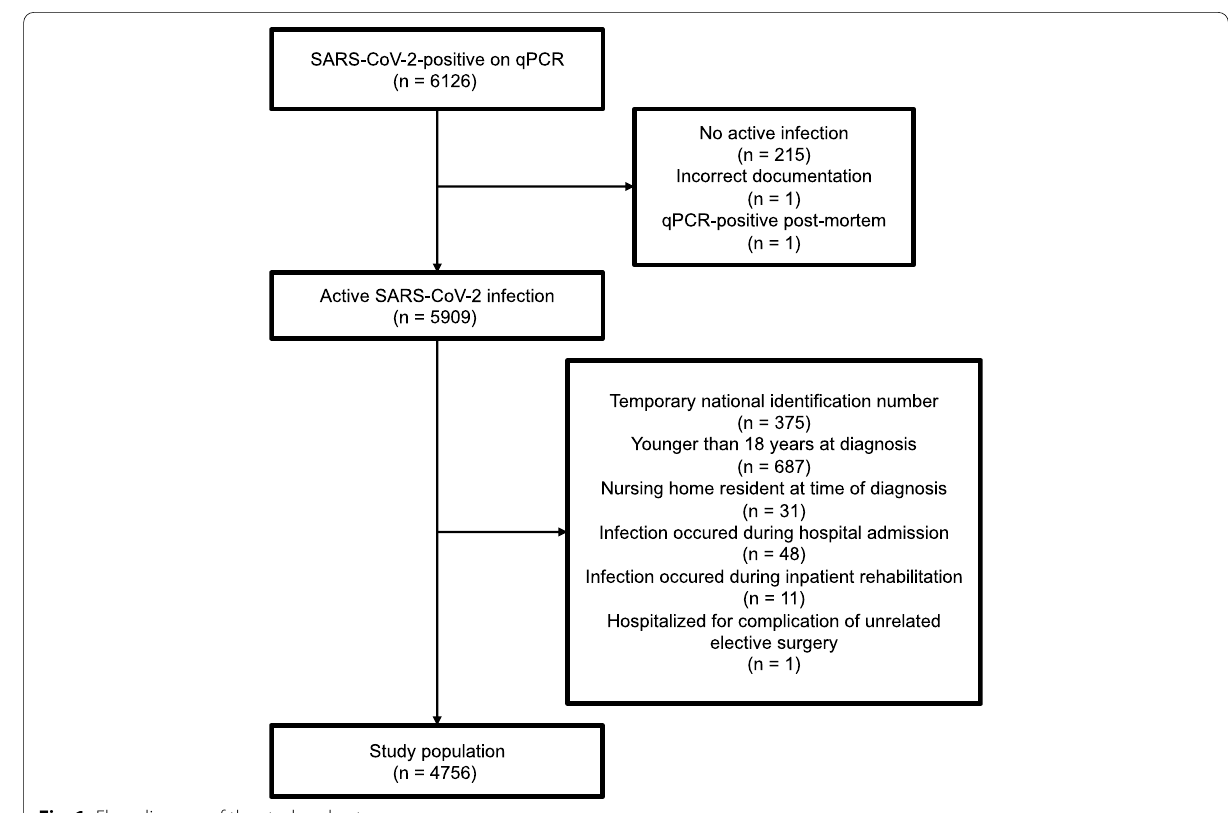
Fig. 1 Flow diagram of the study